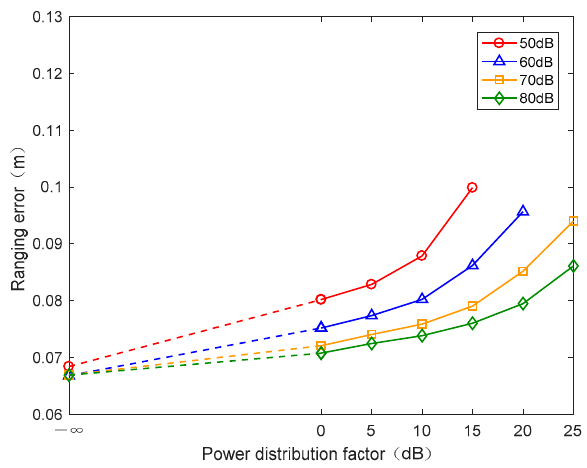
Figure 9. Ranging error in downlink under different CNRs and PWDFs.